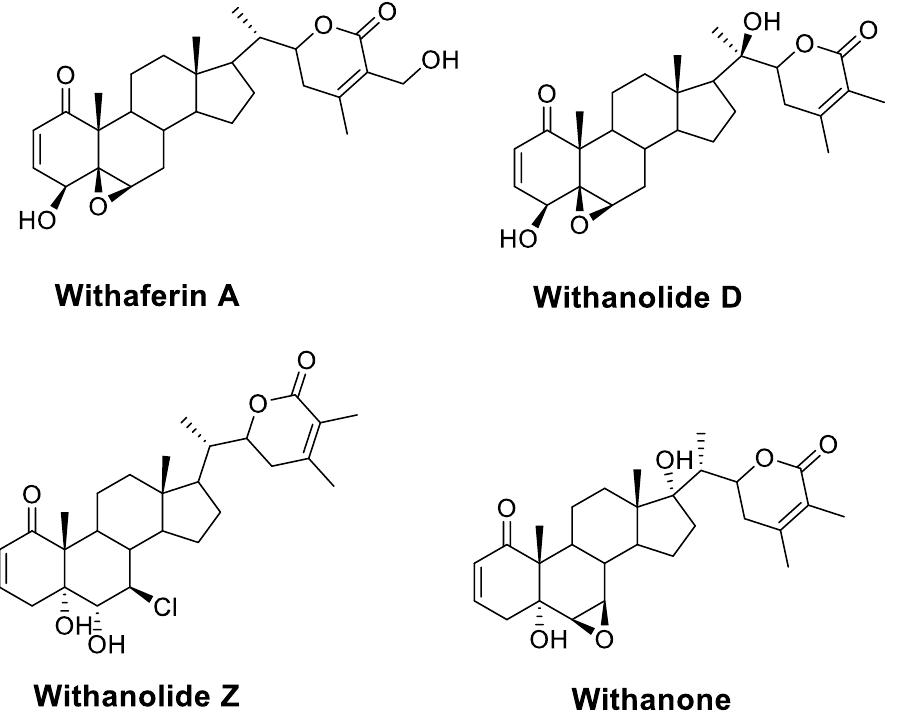
Figure 2. Structural features of bioactive withanolides of W. somnifera represented by withaferin A, withanolides D and Z, and